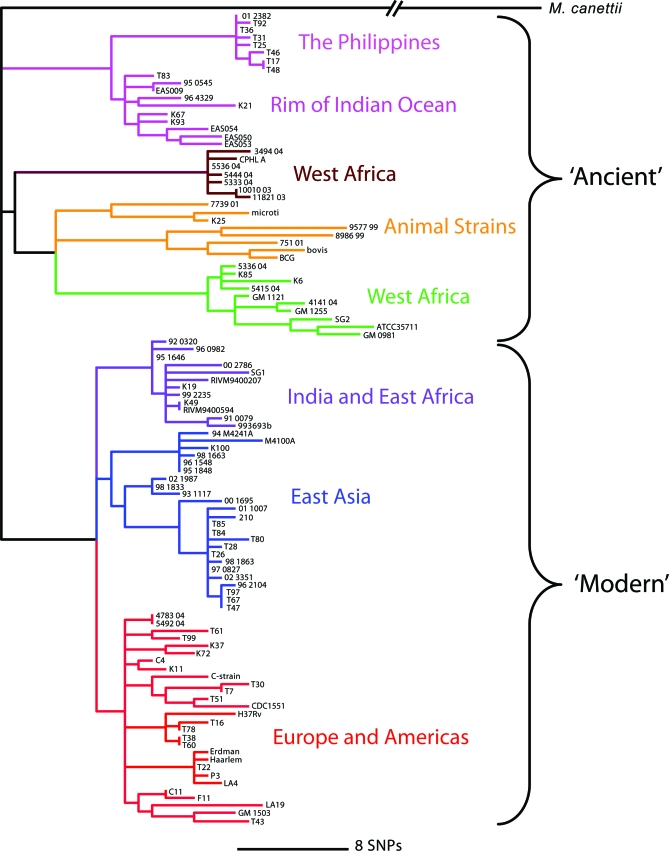
Maximum Parsimony Phylogeny of M. tuberculosis Complex Using 89 Concatenated Gene Sequences in 108 StrainsThe branches are colored according to the main lineages defined previously based on our genomic deletion analysis, except for the animal-adapted strains, which are indicated in orange. The main clades are labeled according to their dominance in particular geographic areas. The branch leading to M. canettii has been truncated in the figure because of the large numbers of changes that separate this hypothesized outgroup from the rest of the phylogeny (Table S4). Ancient and modern strain lineages are indicated. The green and brown lineages correspond to strains traditionally known as M. africanum [21].